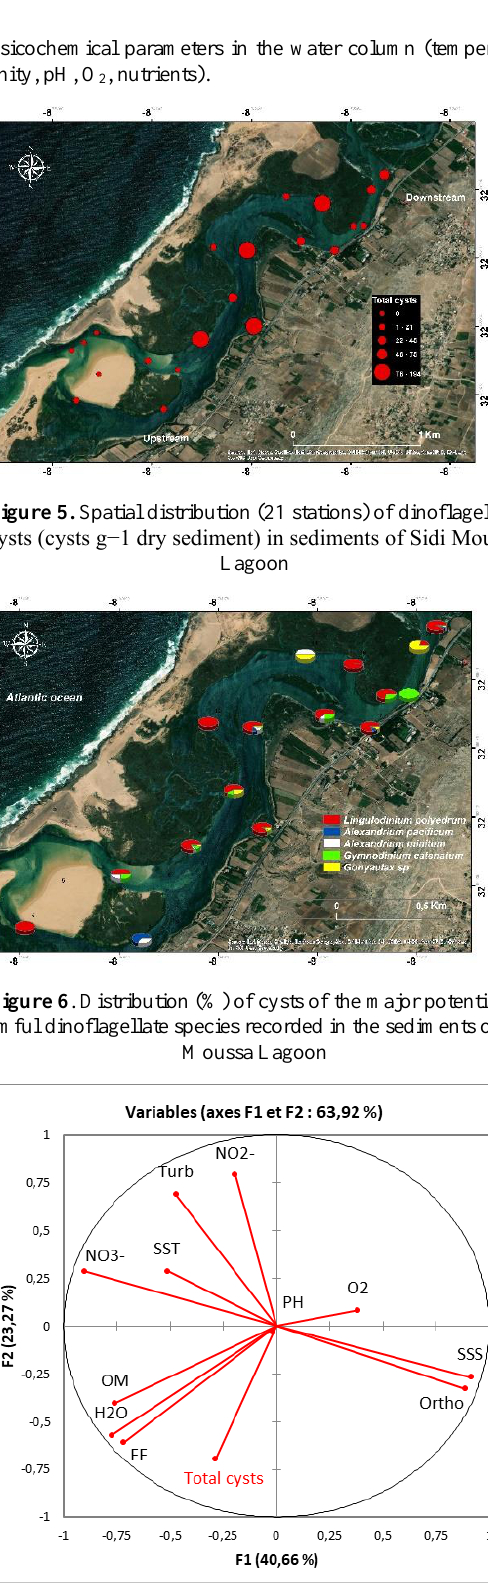
Figure7. Principal components analysis plot showing the positive correlations between dinoflagellate cyst density and organic matter content (%OM), water content (%H2O), and fine fraction (FF) of the sediment. There was no signification correlation with nutrients, water temperature (SST), salinity (SSS), Turbidty(turb), pH or dissolved oxygen